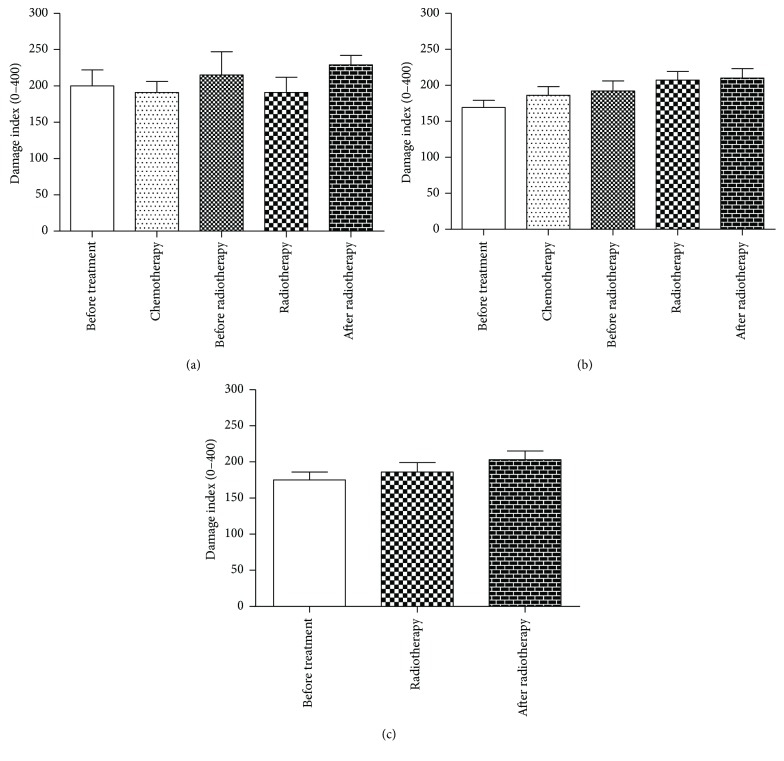
Damage index in relation to the therapeutic regimen: (a) FAC, (b) AC, and (c) RT-isolated.